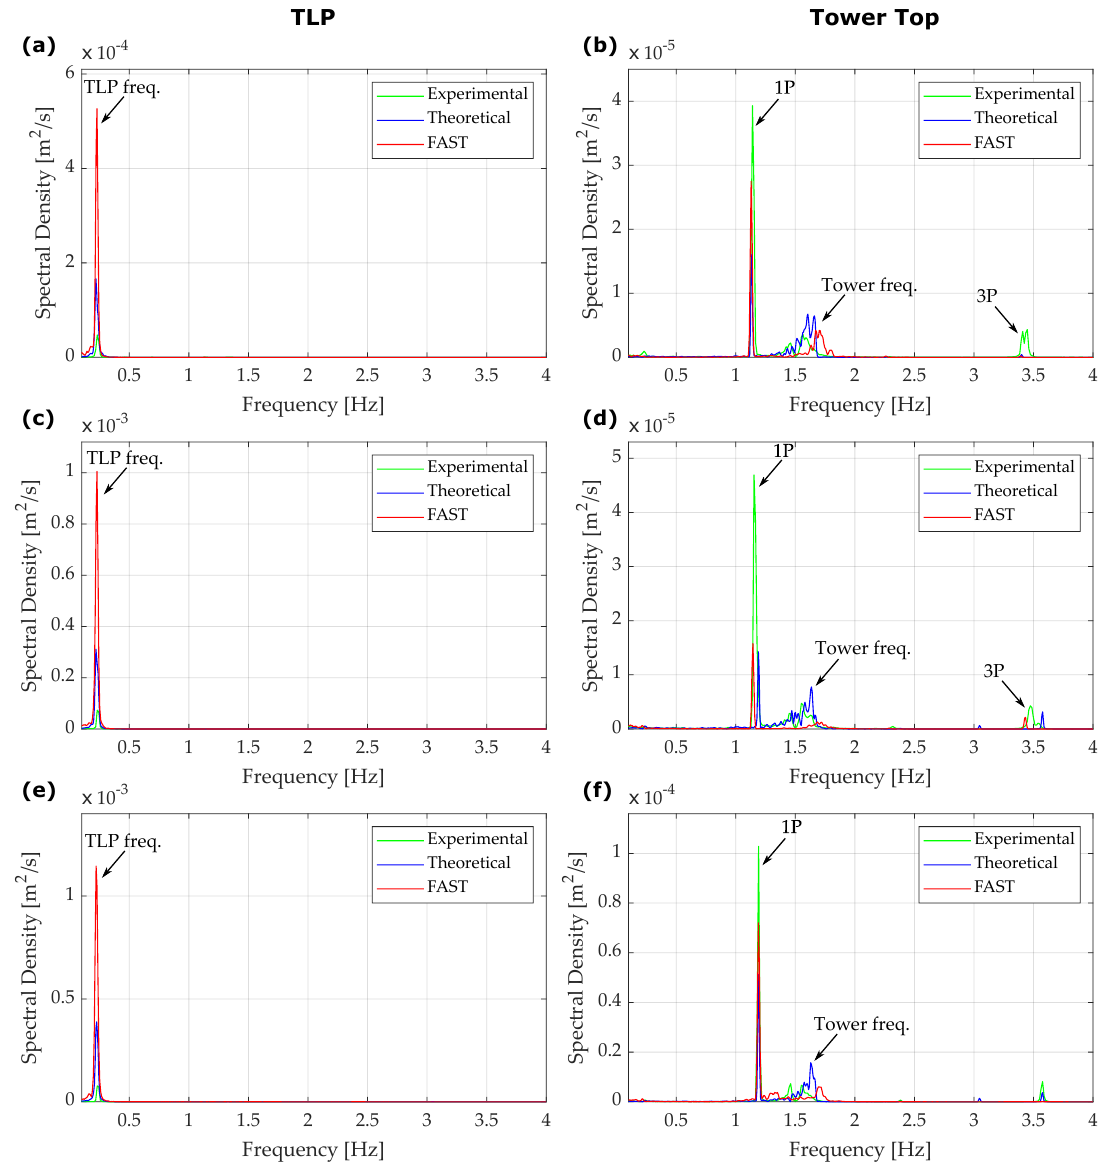
Figure 10. The PSDs of the TLP and nacelles displacement in surge at different wind loads. ( a ) The PSD of the displacement of the TLP at a wind speed of 6 m/s. ( b ) The PSD of the displacement of the tower top at a wind speed of 6 m/s. ( c ) The PSD of the displacement of the TLP at a wind speed of 7 m/s. ( d ) The PSD of the displacement of the tower top at a wind speed of 7 m/s. ( e ) The PSD of the displacement of the TLP at a wind speed of 8.6 m/s. ( f ) The PSD of the displacement of the tower top at a wind speed of 8.6